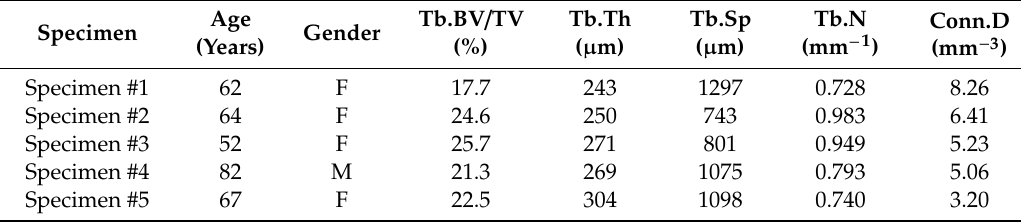
Table 1. Morphometric measurements for all specimens ( n =